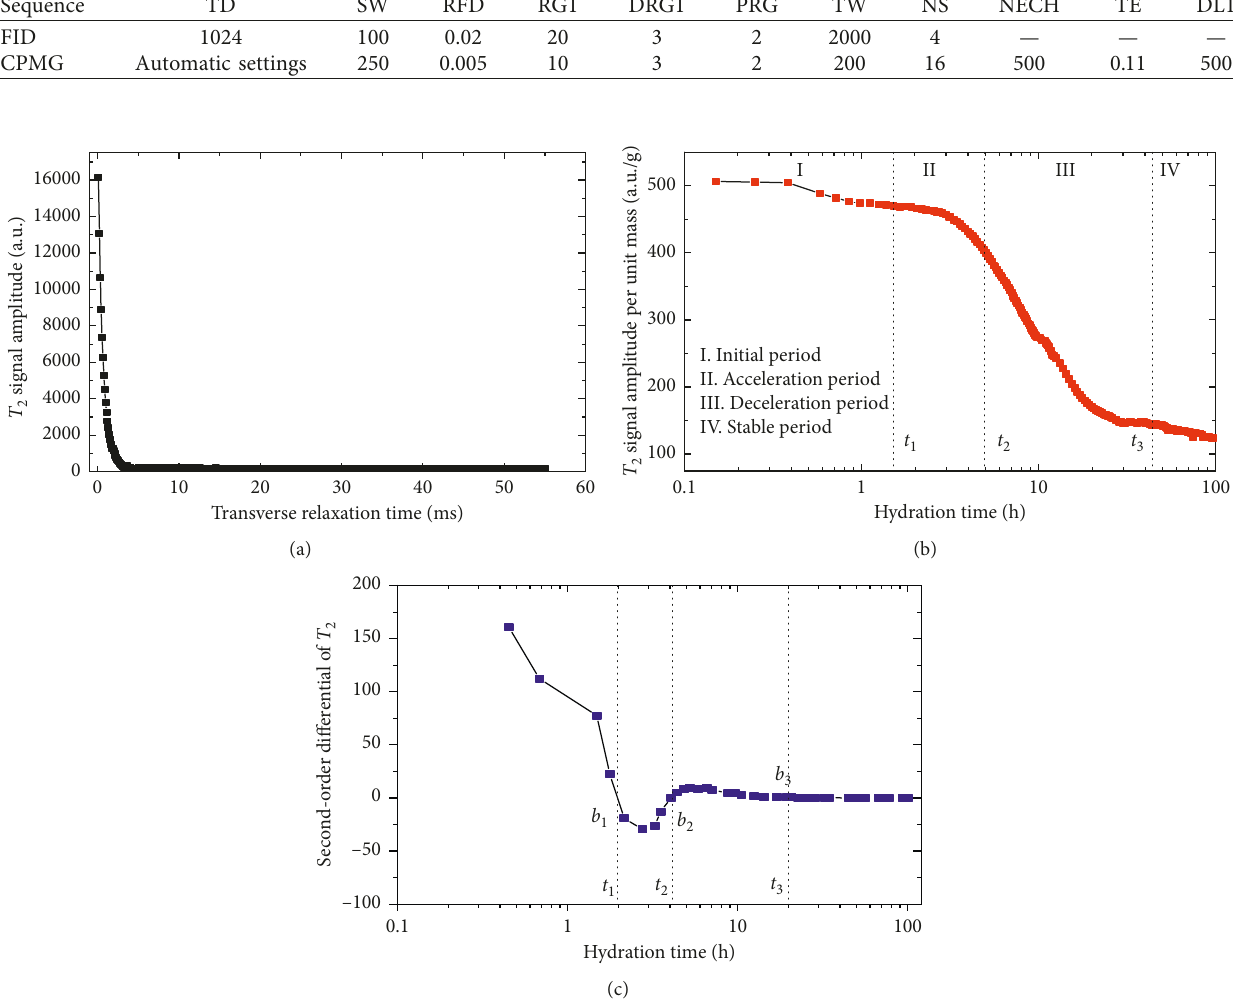
Figure 3: Schematic diagram of hydration process. (a) First wave crest amplitude of ( T mass changes with time. (c) Second-order differential of A ( t